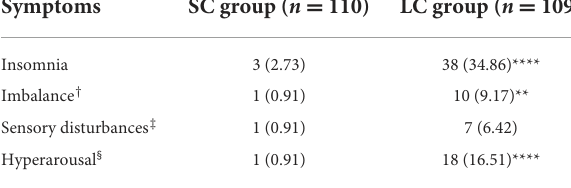
TABLE 2 Symptoms of antidepressant discontinuation syndrome in patients with refractory functional